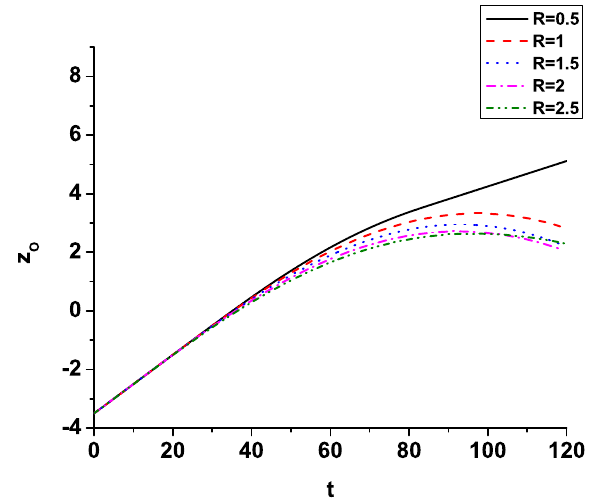
Figure 7 . The path of the object in the collision process with the wall as a function of its radius. On the y-axis we have z O , which represents the location of the center of the object at some moment in time. The parameters are chosen to be m = 5000 . A = 0 . 5 . initial v O = 0 . 1 , while the values for R are marked in the plot. If the radius of the object is small the resistance of the wall is small, and it is easier to go through the wall. Objects of larger radii create greater distortion of the wall and lose more